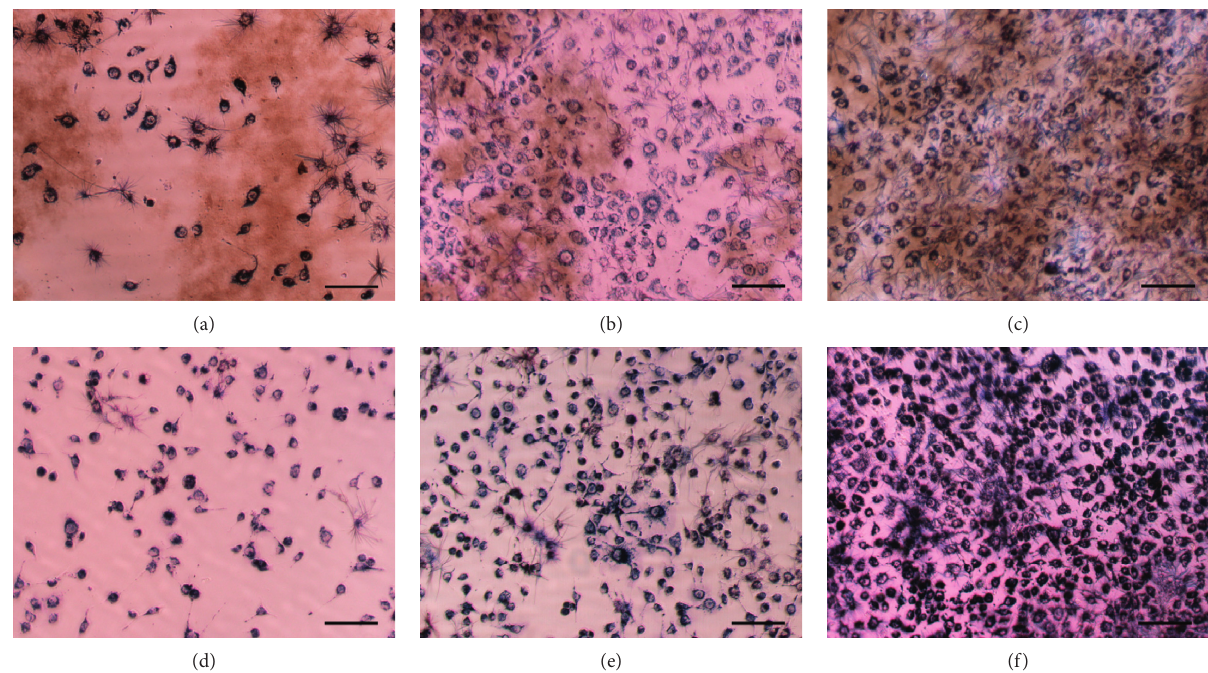
Figure 7: Optical images of HUVEC cells on CS/GO films (a, b, c) and CS films (d, e, f) after cultured 1d (a, d), 2 d (b, e), and 3d (c, f). Cell seeding density is 5000 cells/well. Cells were stained by MTT. The scale is 100 μ m.